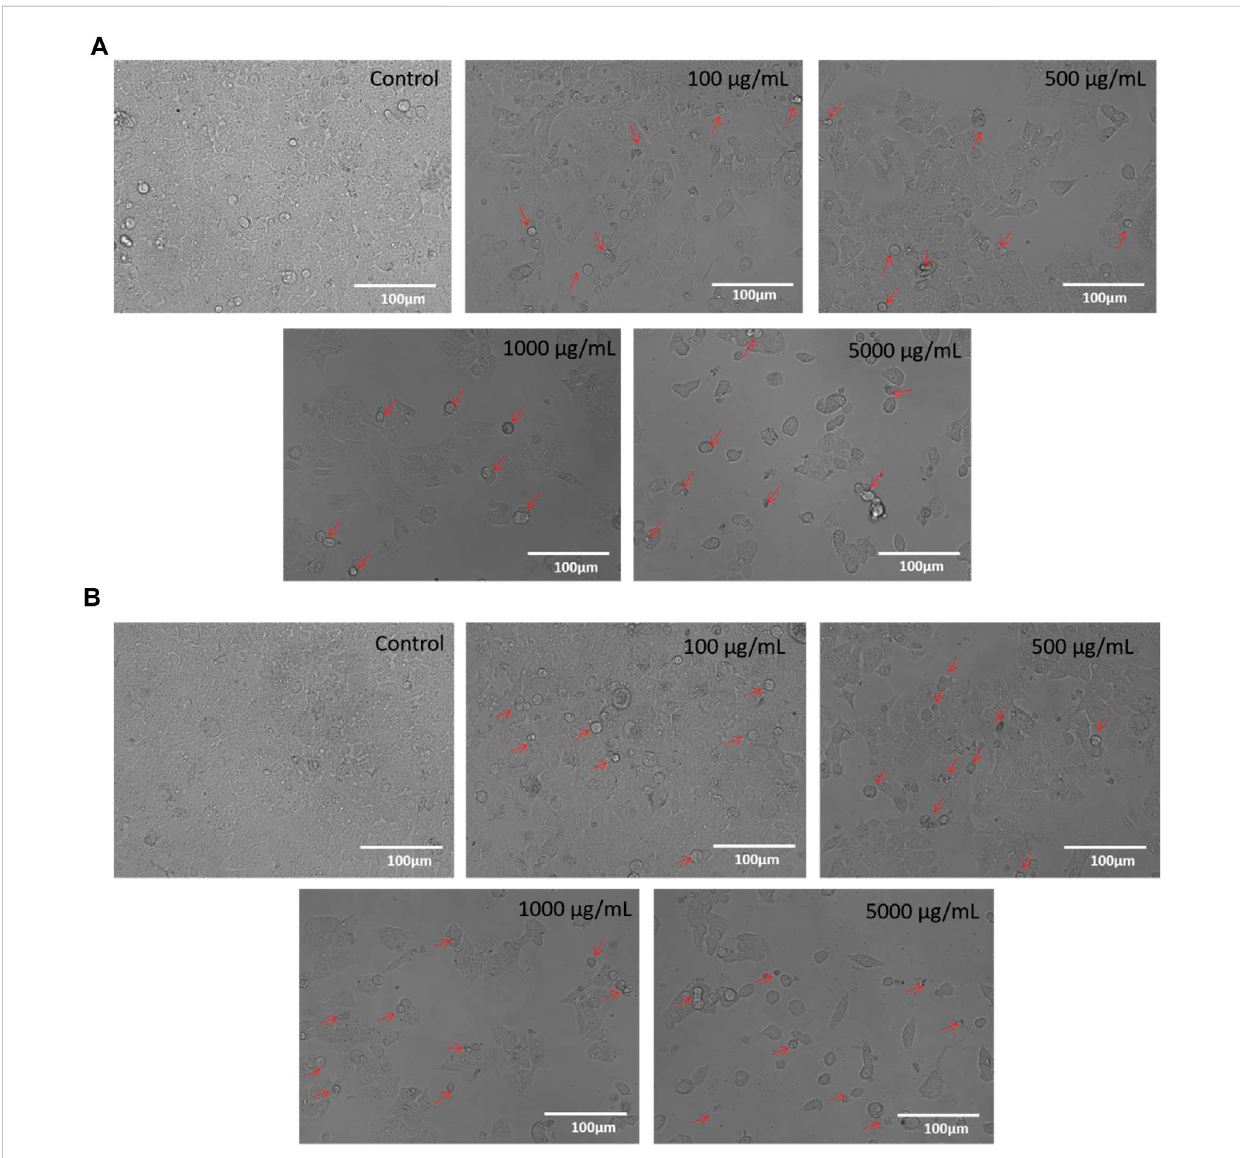
FIGURE 3 (A) :Phase-contrastimagesofHCT-116cellstreatedwitheithervehicleordifferentdosesofM1(100 – 5,000 μ g/mL)for24 h.Thephotomicrographs shown are the representatives of three independent experiments. (B) : Phase-contrast images of HCT-116 cells treated with either vehicle or different doses of M2 (100 – 5,000 μ g/mL) for 24 h. The photomicrographs shown are the representatives of three independent